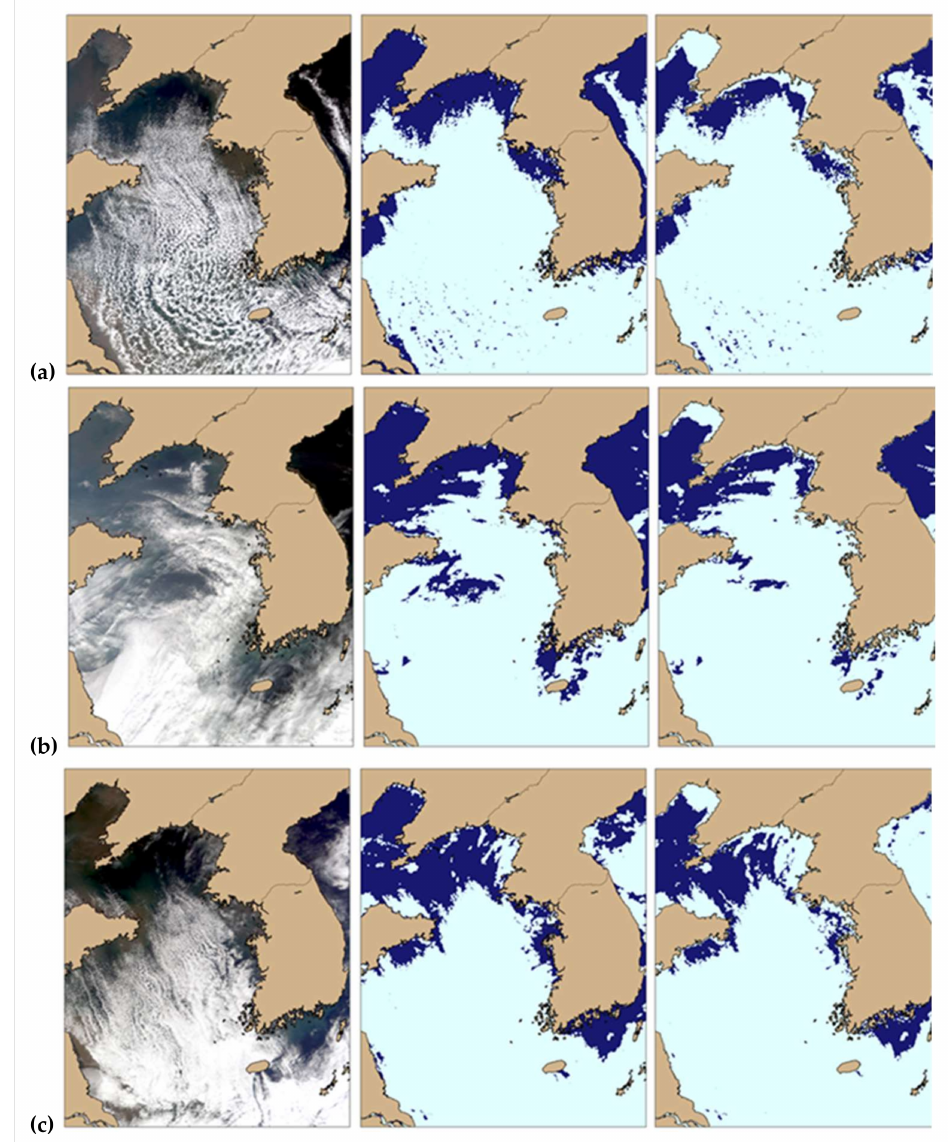
Figure 12. RGB images of a mixture of clouds and sea ice (left column), the proposed CM (middle column), and MODIS CM (right column) on ( a ) 6 January 2011, 02:25 UTC; ( b ) 6 January 2016, 02:15 UTC; and ( c ) 5 January 2018, 02:50